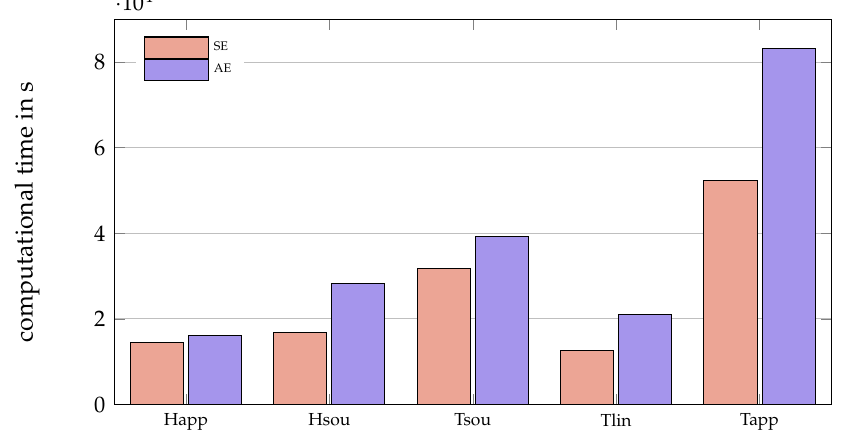
Figure 7. Mean values of the computational time for each solver.